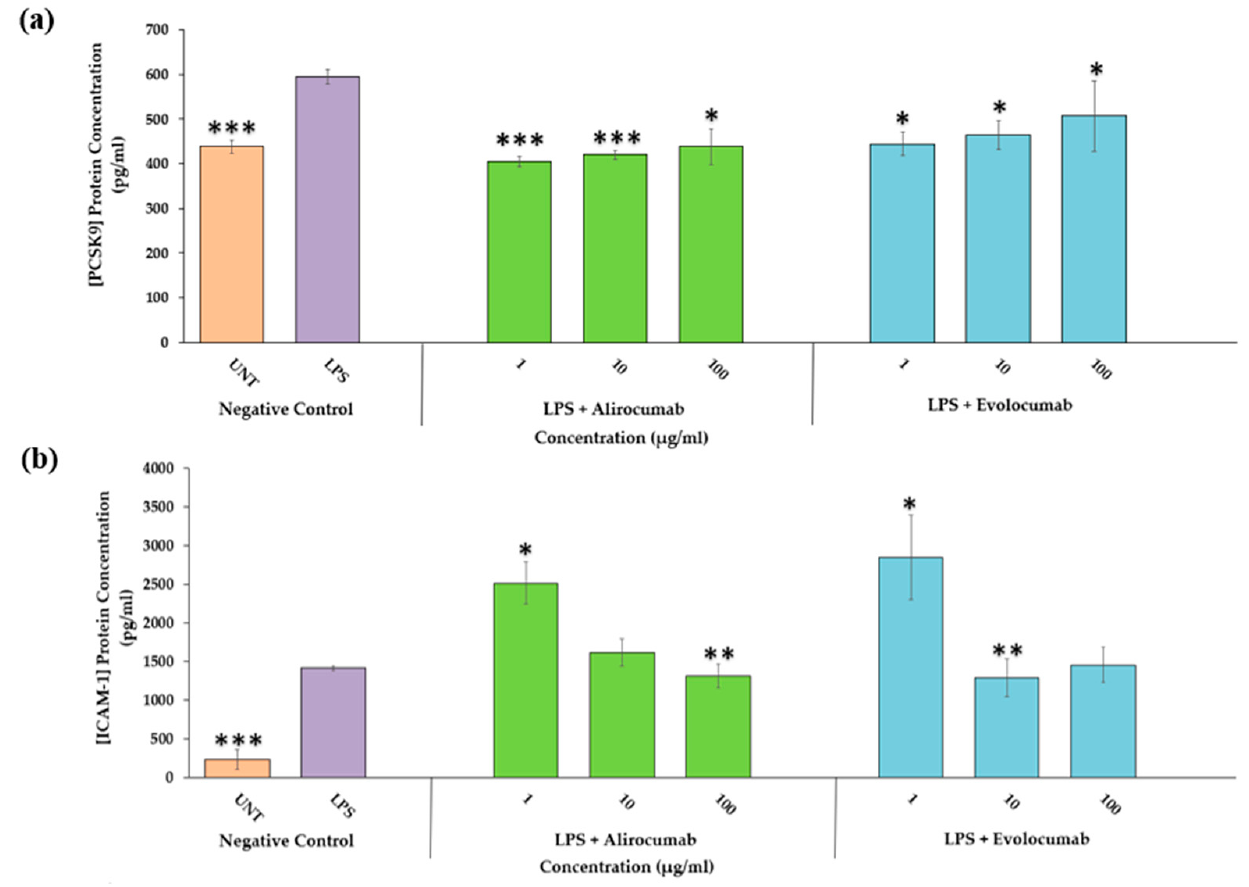
Figure 1. Cytotoxic effects of alirocumab and evolocumab on stimulated HCAEC. Results are presented as percentages (%) of control (untreated cells). Data are expressed as mean ± SD (n = 9). Abbreviation: UNT (Untreated), LPS (Lipopolysaccharides).